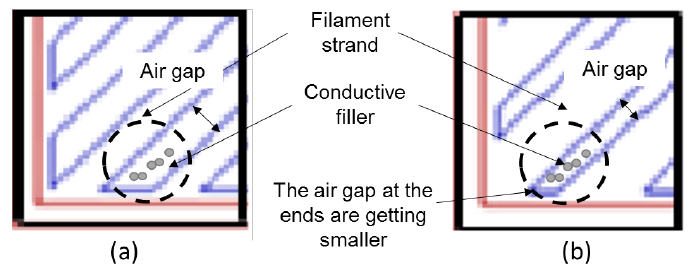
Figure 10. Air gap between filament strands. ( a ) Rectilinear; ( b ) Line (Illustration of toolpath in square sample).